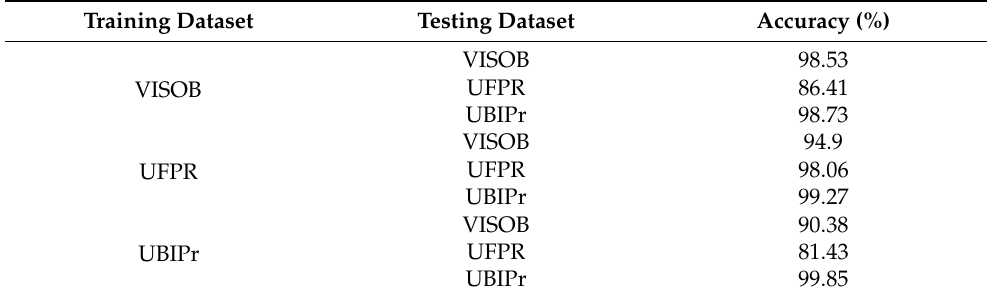
Table 13. The performance of LDA-CNN model on cross-database experiments using VISOB, UFPR and UBIPr datasets.